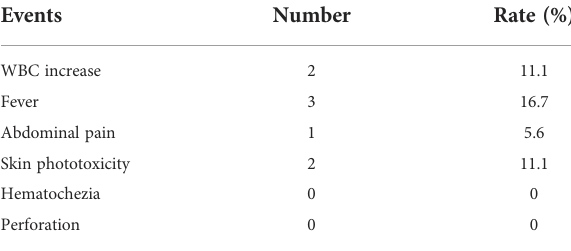
TABLE 4 Toxicities related to